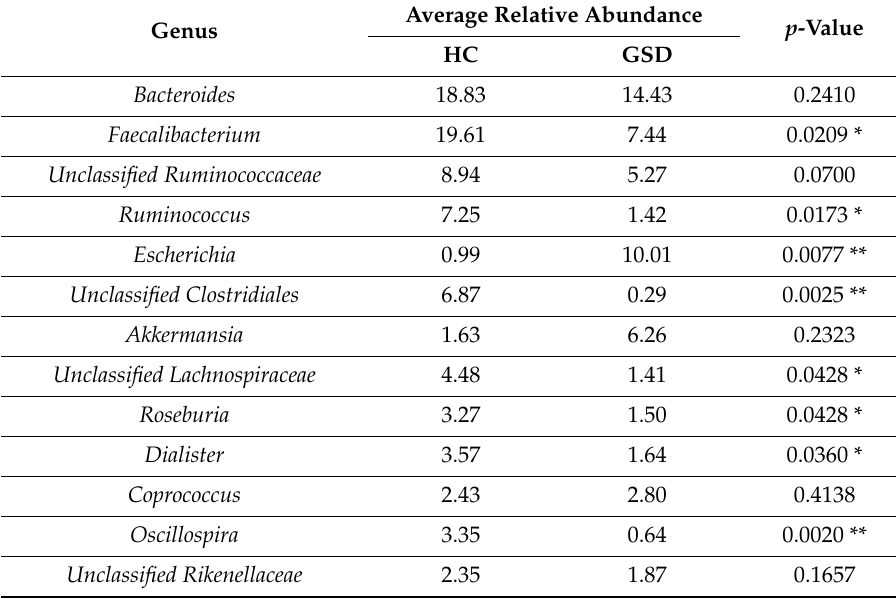
Table 2. Taxonomic relative abundance at the genus level.